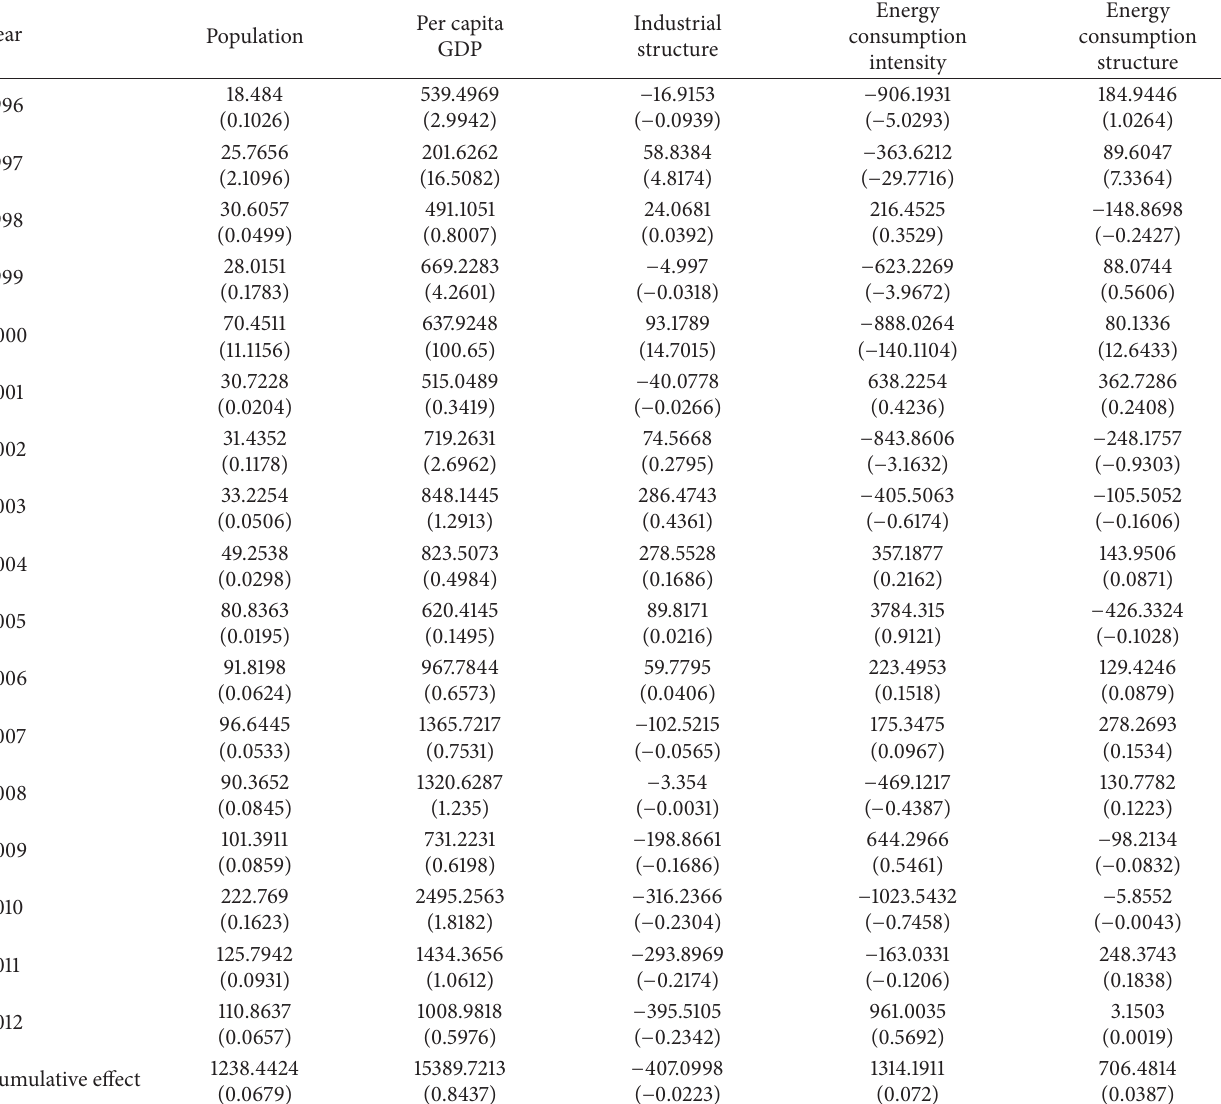
Table 2: Effects of different factors of carbon emissions from energy consumption of Shandong province from 1996 to 2012 by LMDI